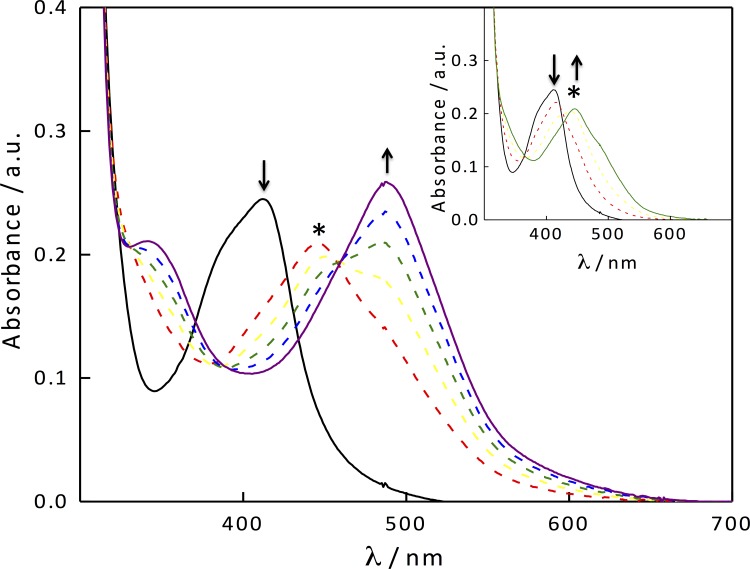
Changes to the electronic absorption of compound 2 (25 μM) in a 2% acetone aqueous solution at irradiation times, tirr, of 0, 3, 5, 7, 10 and 15 min (λirr ≥ 395 nm); the * denotes the mono-aqua intermediate.Inset: tirr = 0.0, 0.5, 1.5, and 3.0 min.